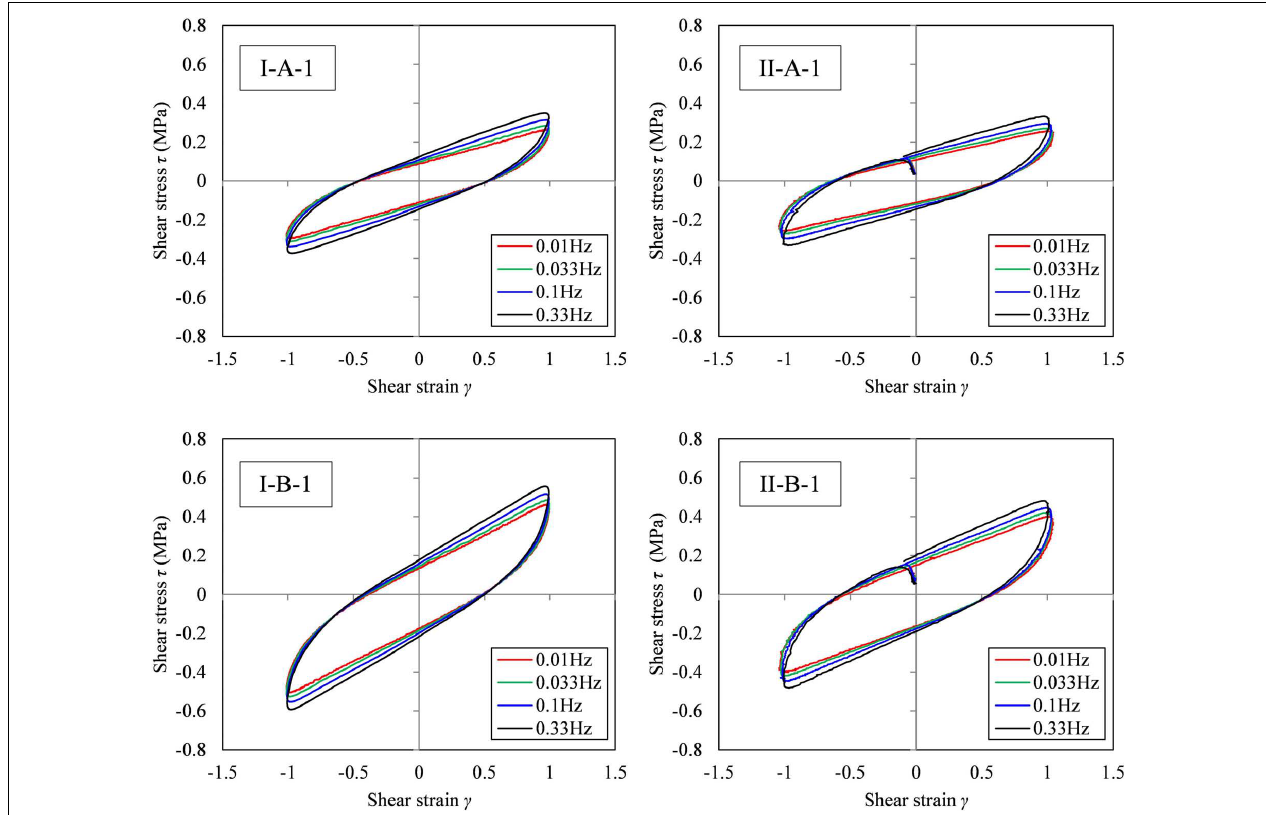
FIGURE 4 | Shear stress-strain relationship of scale-I and -II in frequency dependence test at 3rd cycle.